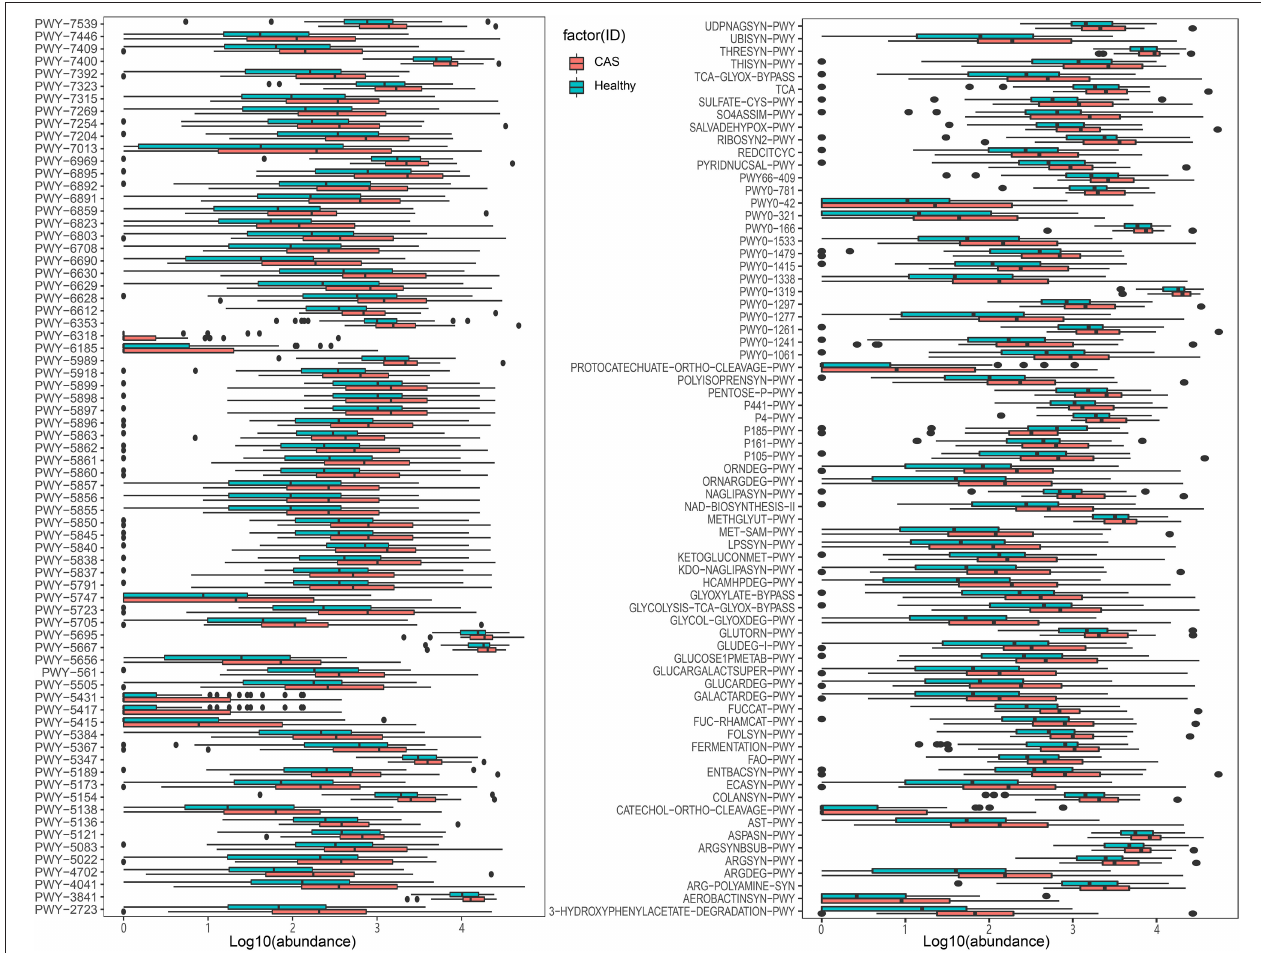
FIGURE 4 | MetaCyc pathways with differences in abundance between the healthy control and carotid arteriosclerosis (CAS) groups ( p < 0.05, Wilcoxon’s rank-sum